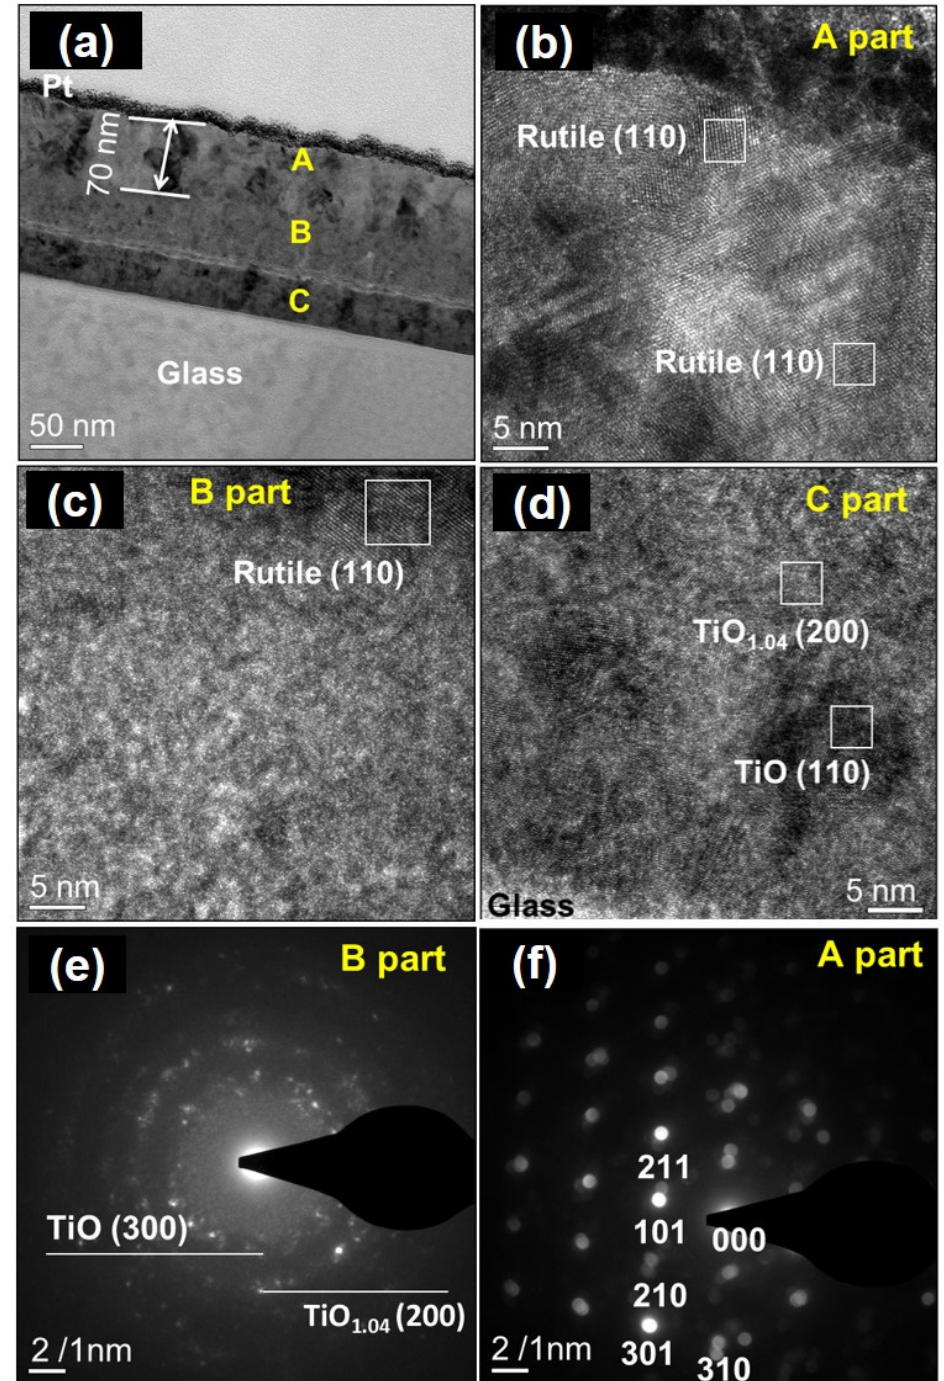
Figure 5. TEM micrographs of a sample 2 thin-film thermally oxidized at 450 ◦ C: ( a ) plane view of the film, ( b ) HR-TEM image showing point A, ( c ) HR-TEM image showing point B, ( d ) HR-TEM image showing point C, ( e ) NBED showing point B, and ( f ) NBED showing point A.